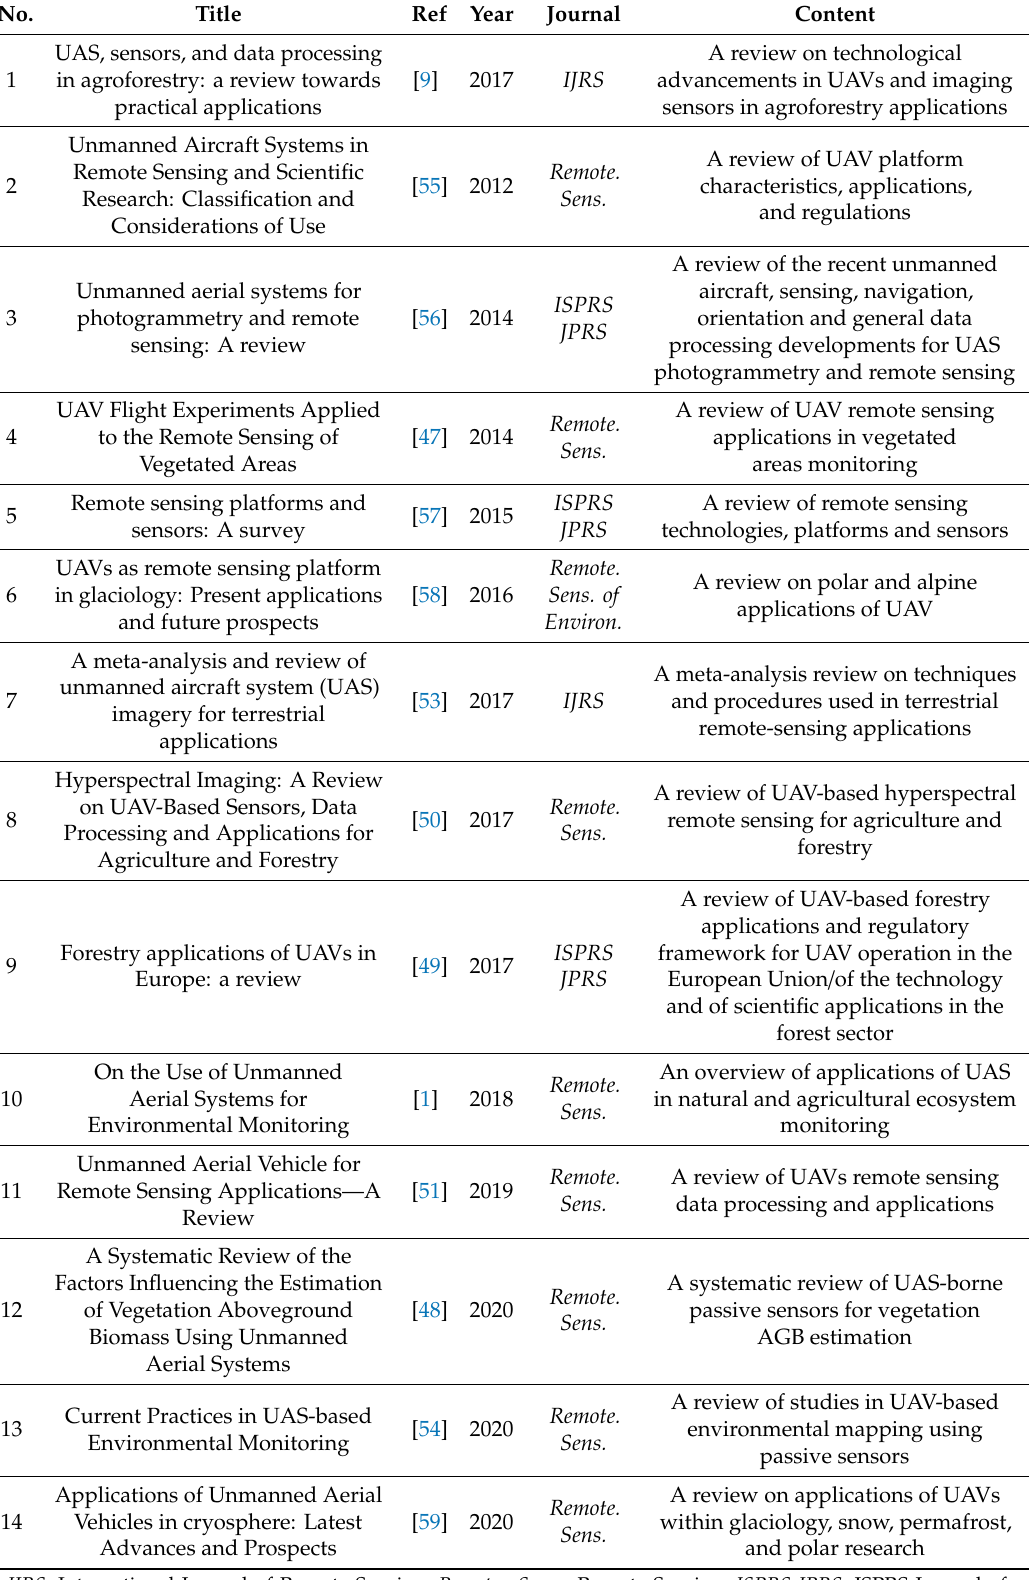
Table 1. Related review studies on Unmanned Aerial Vehicle (UAV) remote sensing.